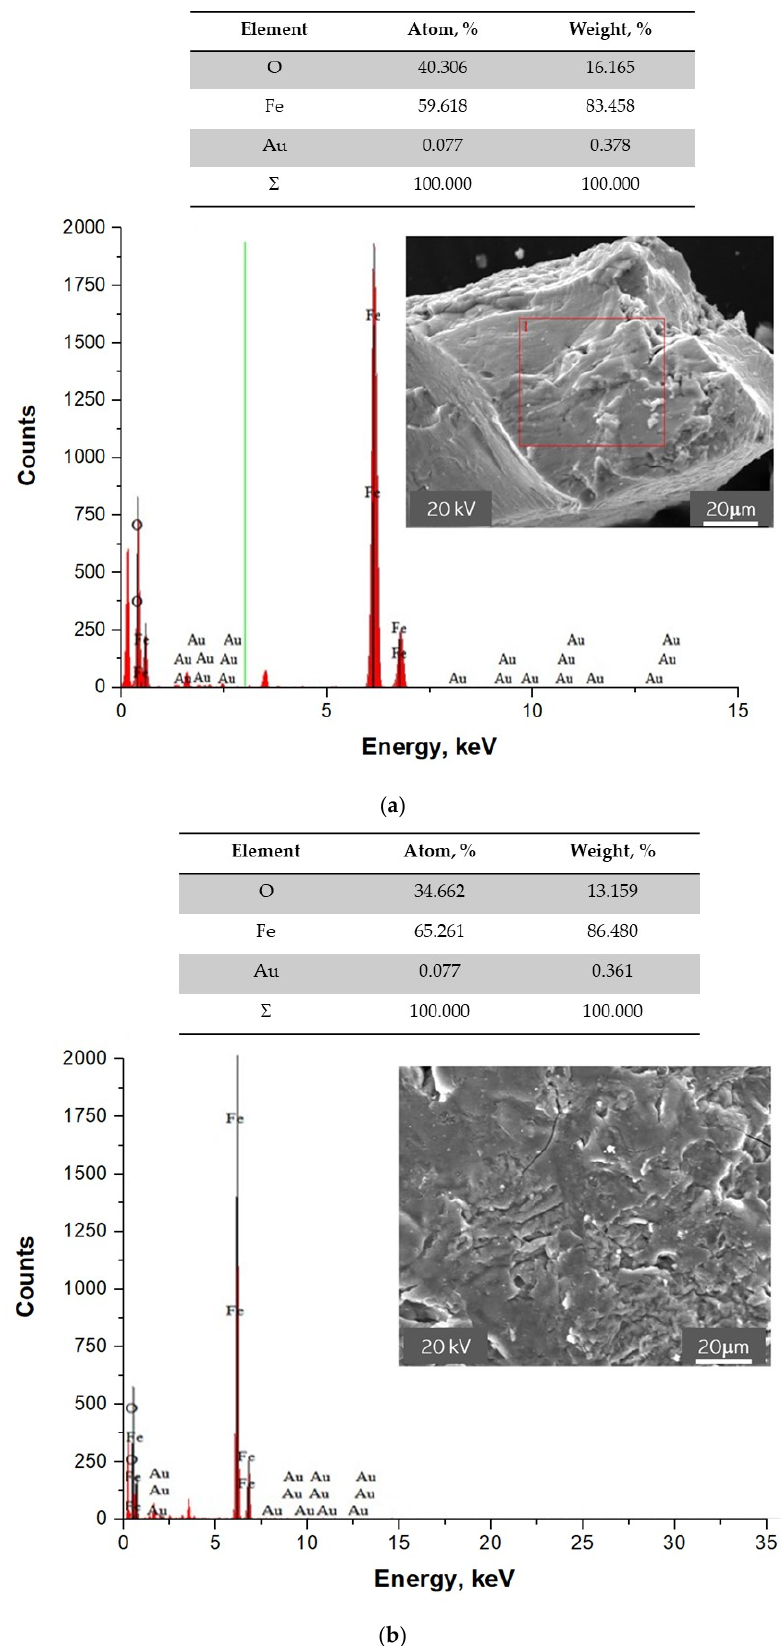
Figure 11. SEM images of Fe 3 O 4 @Au nanoparticles supported with EDS analysis of two points ( a , b ).